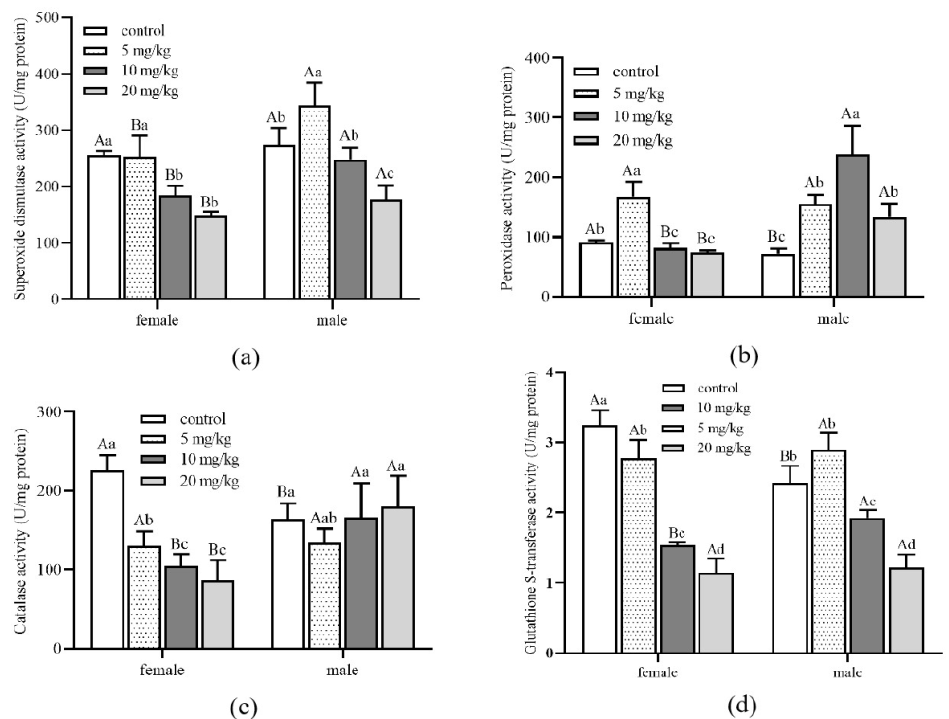
Figure 5. Detoxification enzyme activity of Aleuroglyphus ovatus under different concentrations of Cd stress in female and male adults. ( a ) Activity of superoxide dismutase (SOD); ( b ) Activity of peroxidase (POD); ( c ) Activity of catalase (CAT); ( d ) Activity of glutathione S-transferase (GST). Results are expressed as mean ± SD. Different uppercase letters indicate significant differences between female and male adults at the same Cd concentration ( p < 0.05). Different lowercase letters indicate significant differences among control and treatment groups in female and male adults ( p <